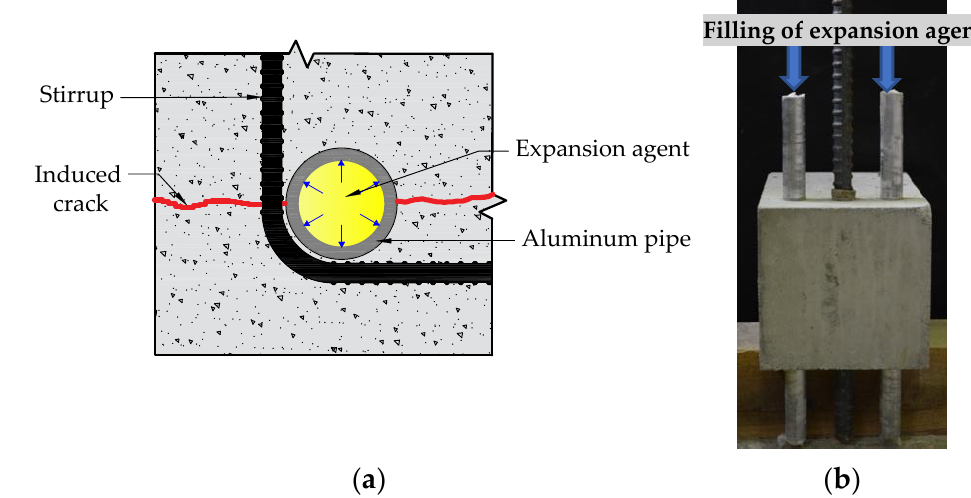
Figure 7. Concrete cracking with an EAFP: ( a ) cracking process; ( b ) expansion agent filling.